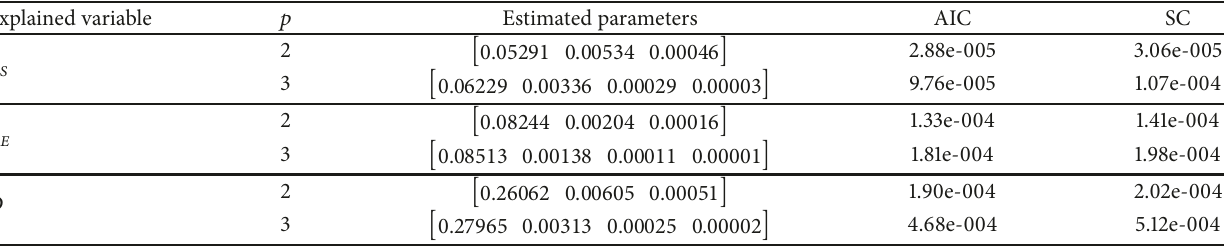
Table 5: Fitting equation parameters and AIC and SC results for socio-economic development and environmental pollution scores and coupling coordination degree of the BTH